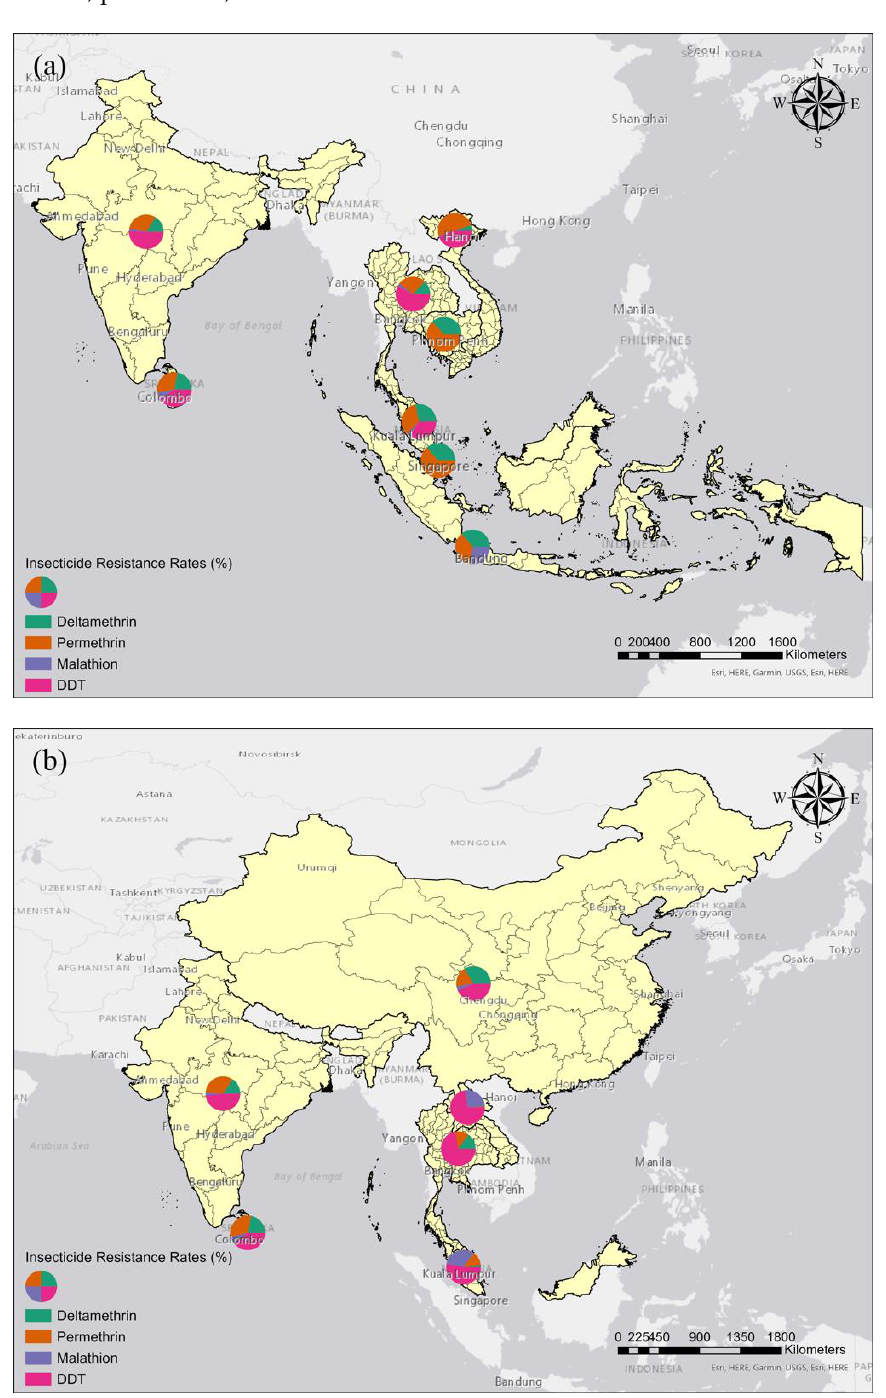
Figure 5. Resistance rates for the four major insecticides in each country/region. ( a ) Ae. aegypti. ( b ) Ae. albopictus .